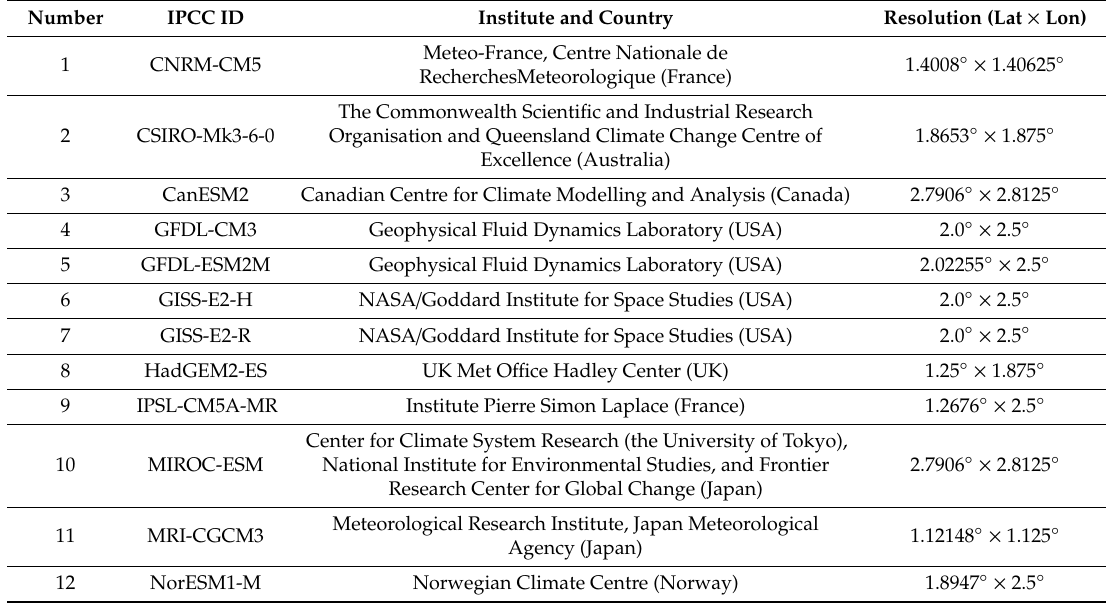
Table 1. CMIP5 models used in this study. Data resolution information is obtained from